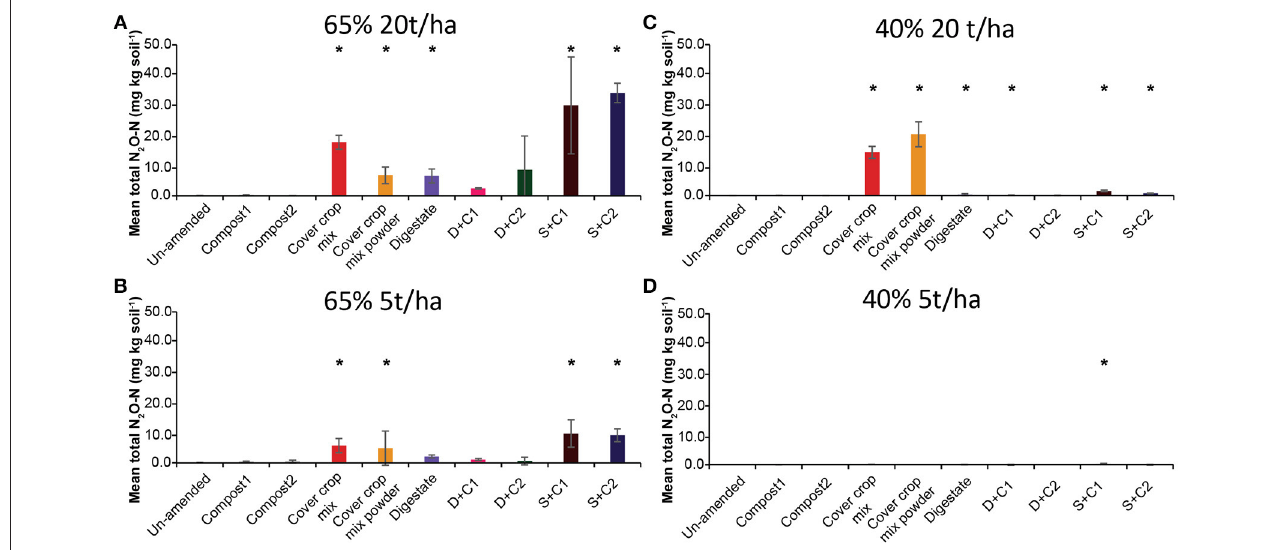
FIGURE 3 | Mean total N 2 O emitted over the period of 28 d in un-amended clay soil and after amendments with compost1, compost2, CC residues mixtures, digestate, digestate + compost1, digestate + compost2, sewage sludge + compost1, and sewage sludge + compost2 (mean ± SD; n = 3) at (A) high amount (20 t/ha) and high water content (65%), (B) low amount (5 t/ha) and high water content, (C) high amount and low water content (40%), and (D) low amount and low water content, derived from the cumulative N 2 O ( Supplementary Figure 3 ) fluxes. Asterisk (*) indicate significant differences in the mean total N 2 O fluxes between the soils with organic amendments and the un-amended soil within the four separate superordinate treatments (ANOVA: P < 0.05).